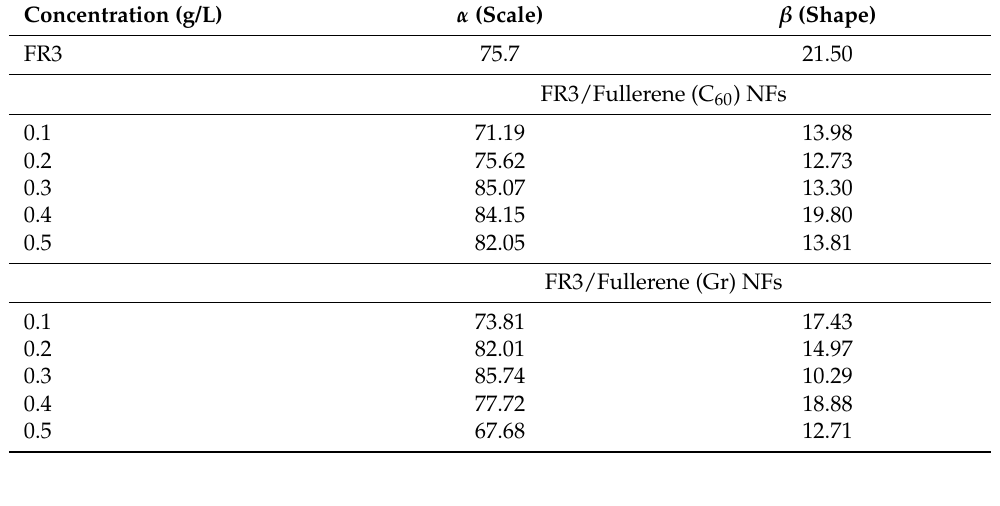
Table 6. Scale and shape parameters.